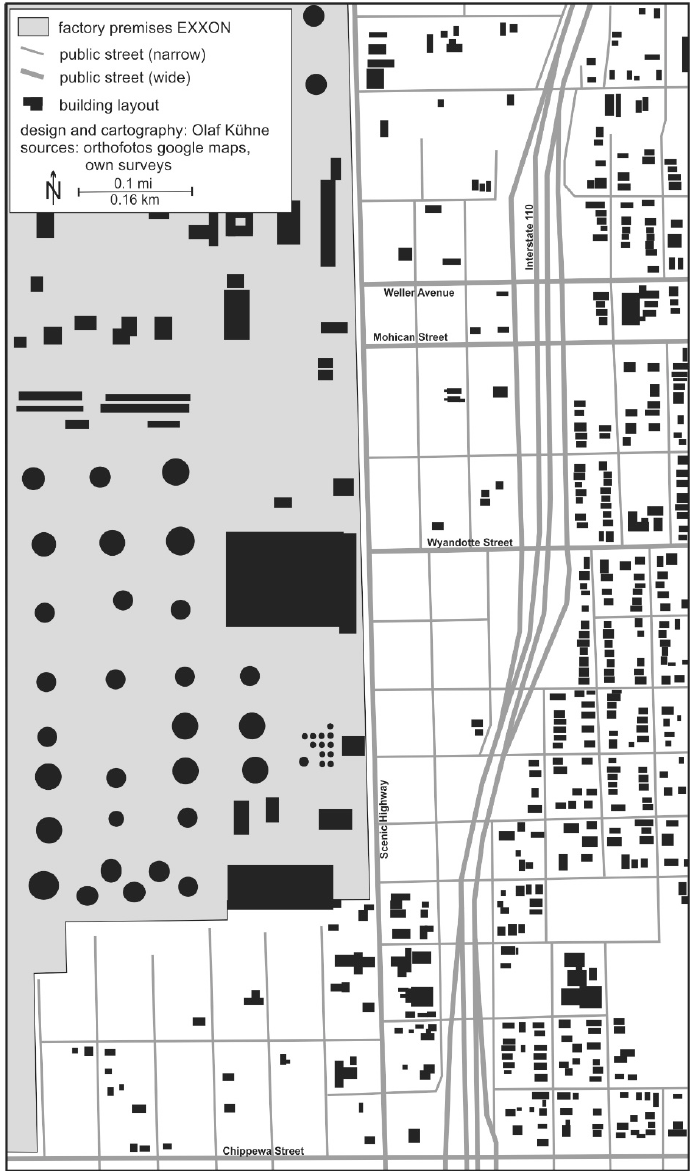
Figure 8. The layout west of the Exxon site in February 2019, with the acquisition and demolition of buildings, the layout west and east of Interstate 110 is in stark contrast (own illustration [37]). In 2005, Hurricane Katrina brought numerous New Orleans refugees to the city, combined with emergency shelters, traffic chaos, and the supporting solidarity (eventually overwhelming) of Baton Rouge residents. Not all New Orleanians returned home, which brought a restrained population surge, intensifying the rivalry between the two Louisiana metropolises [40]. On the whole, the community development in the Baton Rouge metropolitan region today is shaped by a simultaneity of centrifugal and centripetal forces: There are clear efforts to revitalize the downtown area by increasing residents, development of restaurants and hotels, offices, etc., concurrently, there are also clear efforts to develop the city’s infrastructure. Hitherto unincorporated suburban communities of East Baton Rouge Parish are making efforts to incorporate (currently in the south: St George), ultimately to be able to reduce tax burdens for the proposed community residents. This makes financing the public school system difficult for the districts east of the ExxonMobil refinery that are especially affected by the gradual de-industrialization